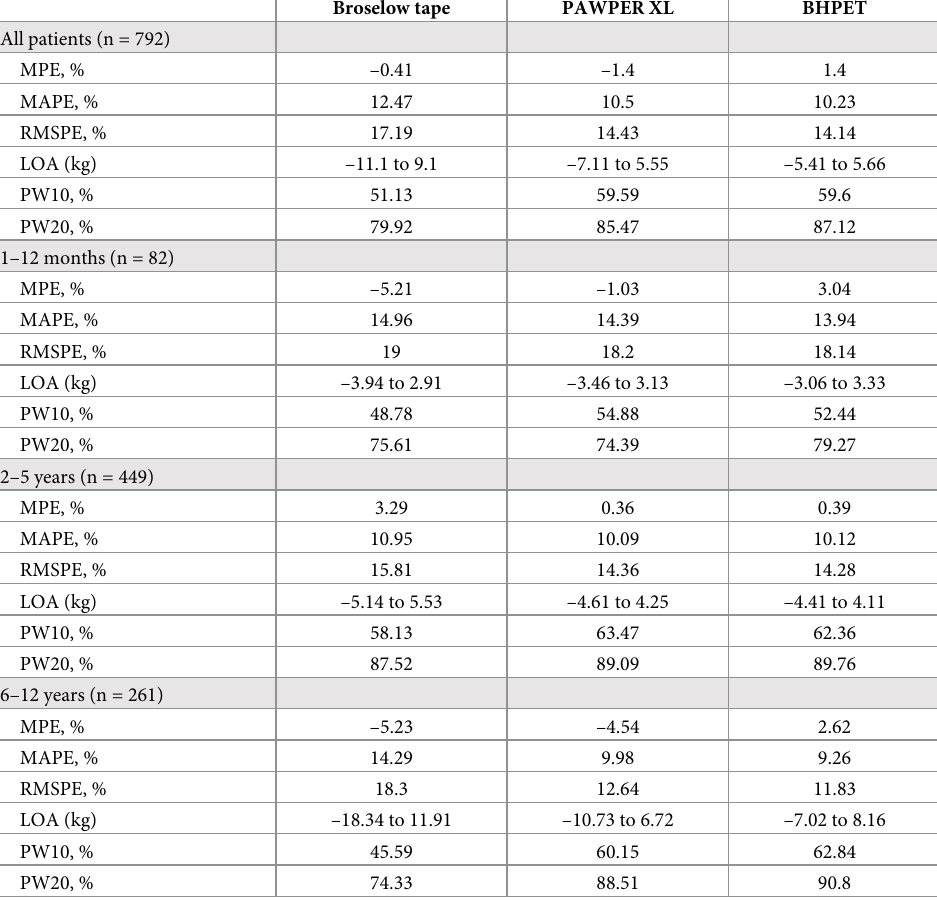
Table 2. Performance data for the Broselow tape, PAWPER XL tape, and BHPET.